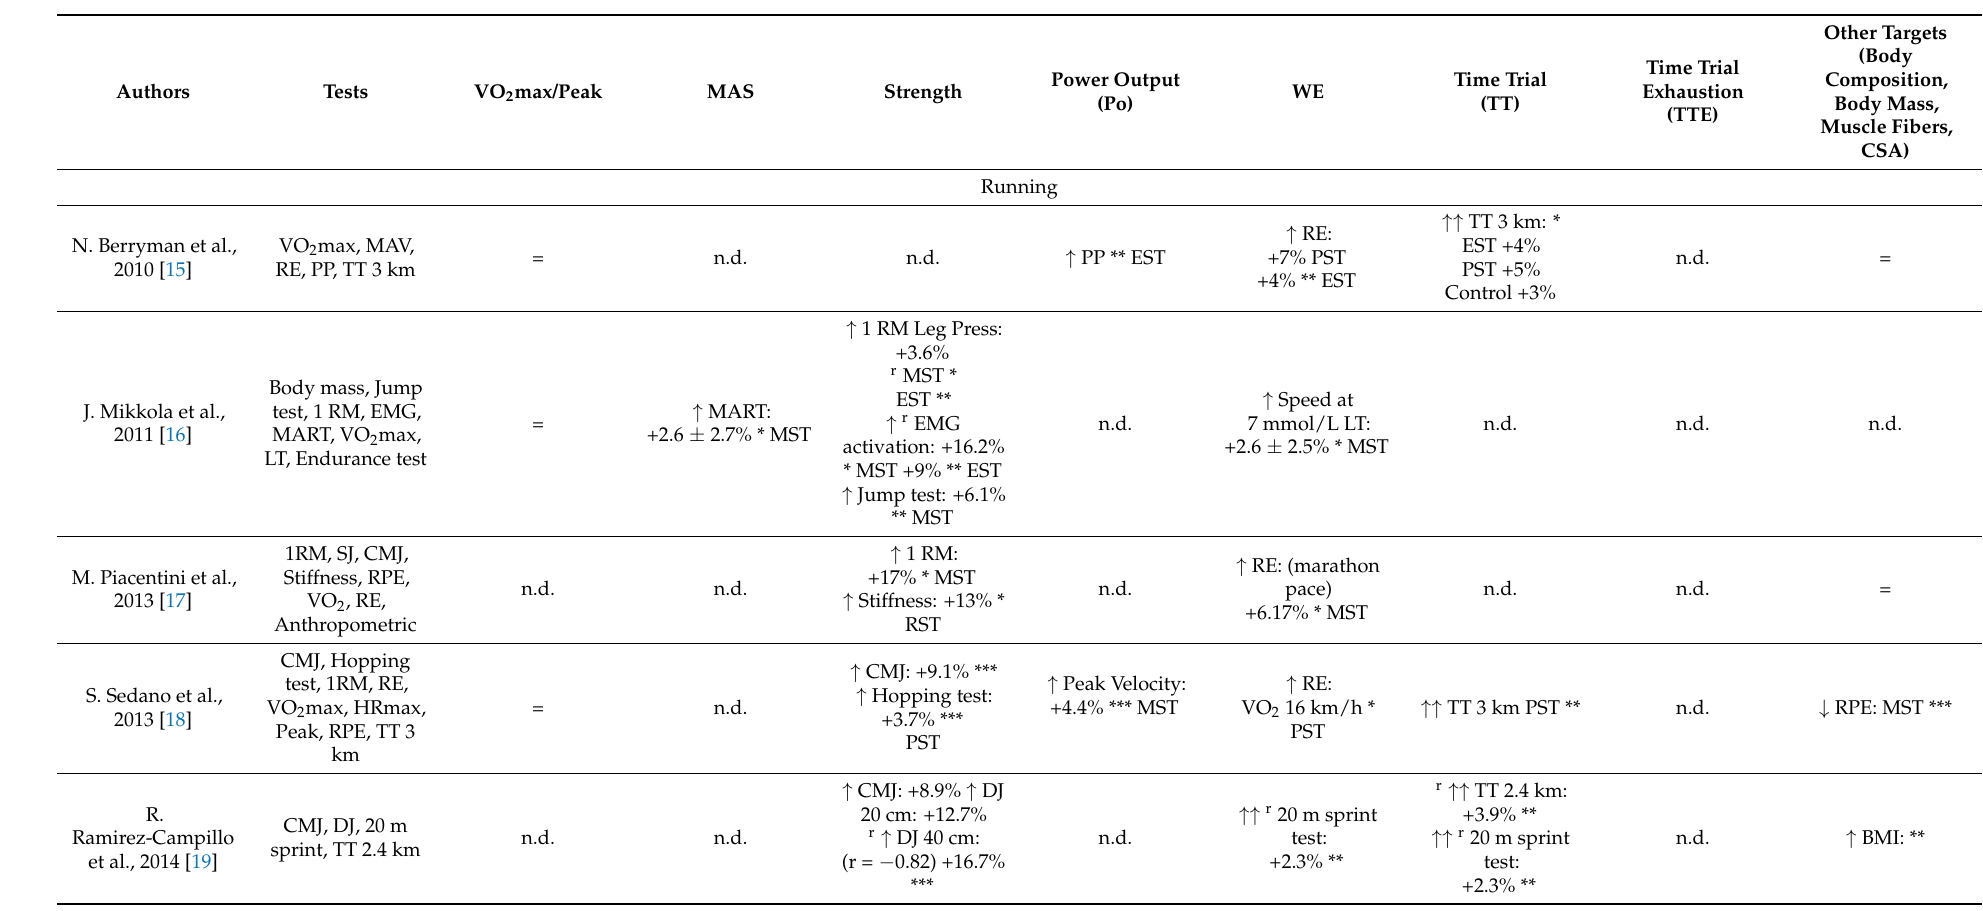
Table 4. Effect of NST on sport